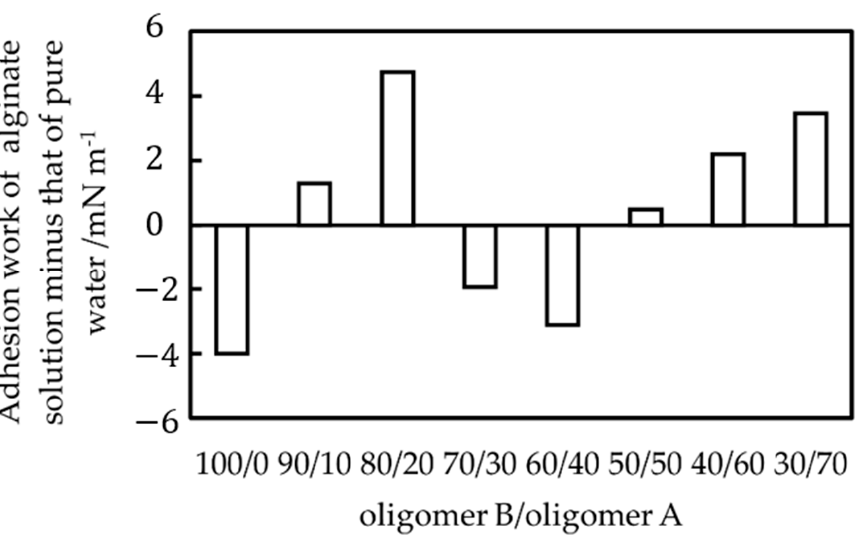
Figure 7. Effect of substrate species on the adhesion work of an alginate solution minus the adhesion work of pure water.